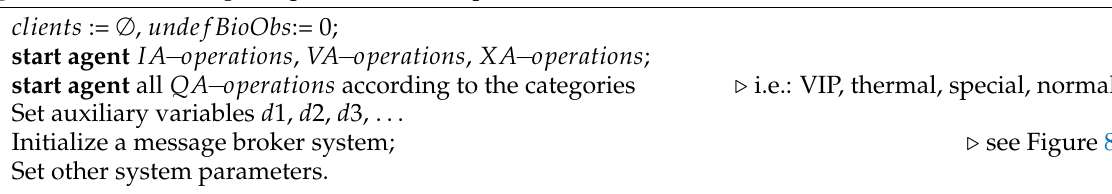
Algorithm 1 The MA agent operations (MA-operations).